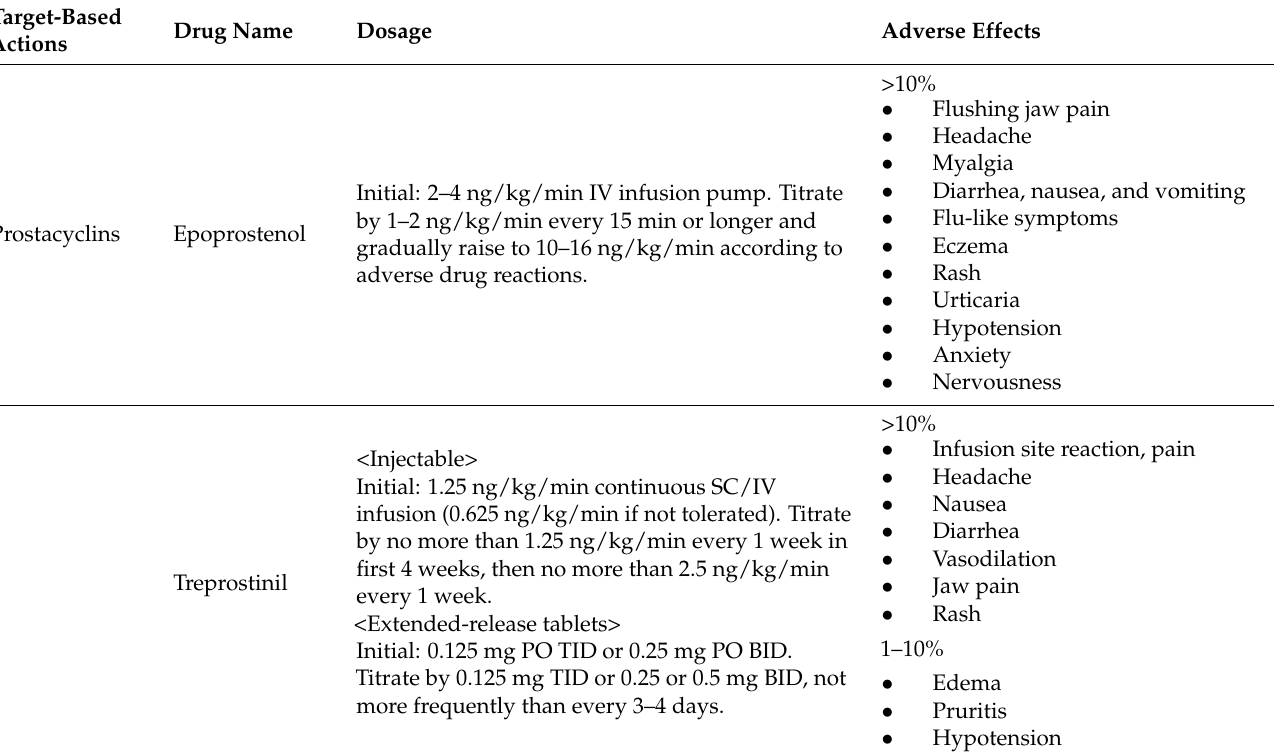
Table 1. First-line drugs for targeting endothelial dysfunction for